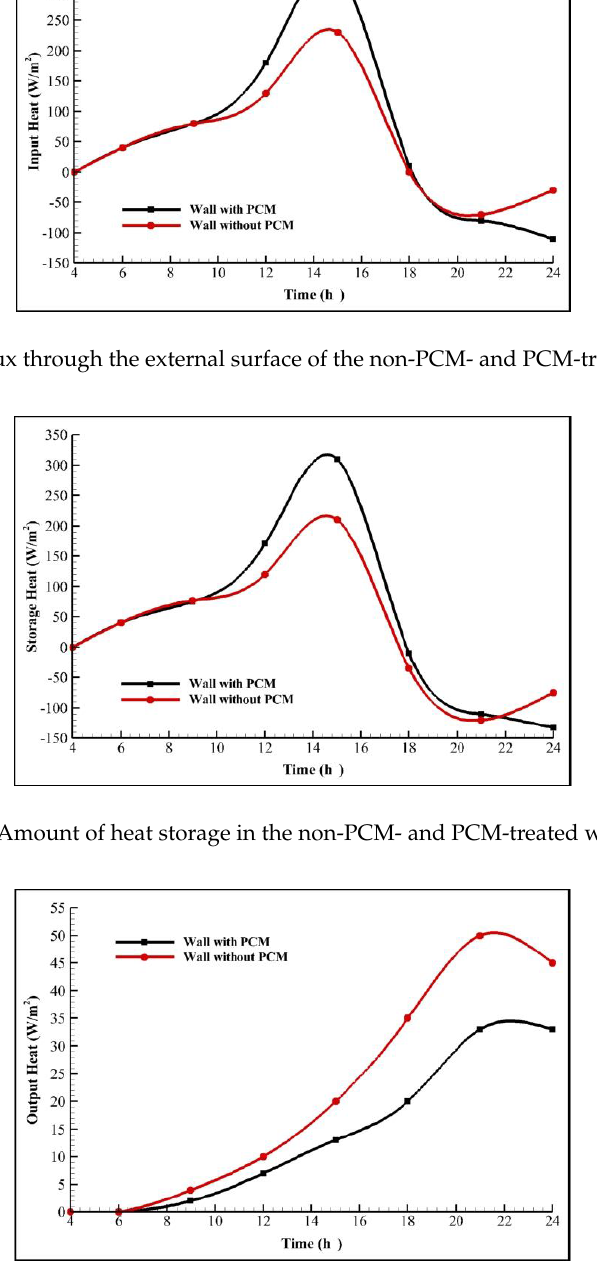
Figure 15. Heat flux through the internal surface of the non ‐ PCM ‐ and PCM ‐ treated west walls.